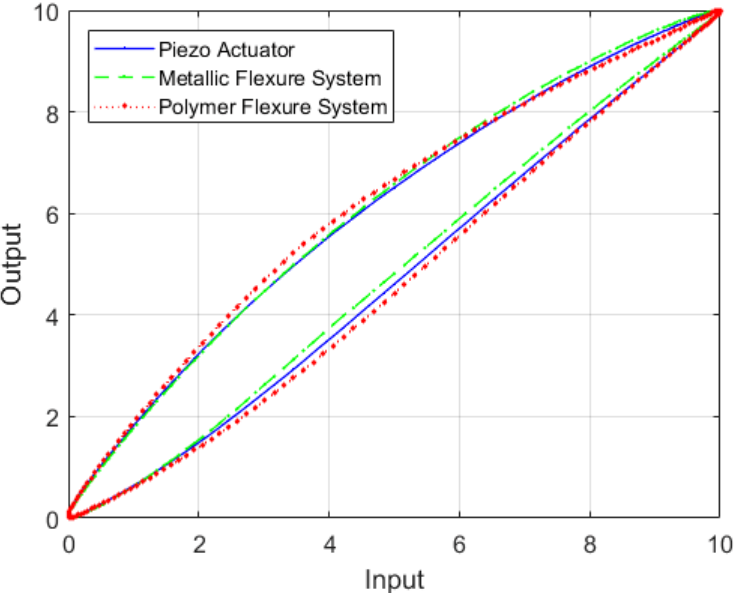
Figure 1. The hysteresis behavior of a piezoelectric actuator, a piezo-actuated metallic flexure-based system and a piezo-actuated polymer flexure-based system after